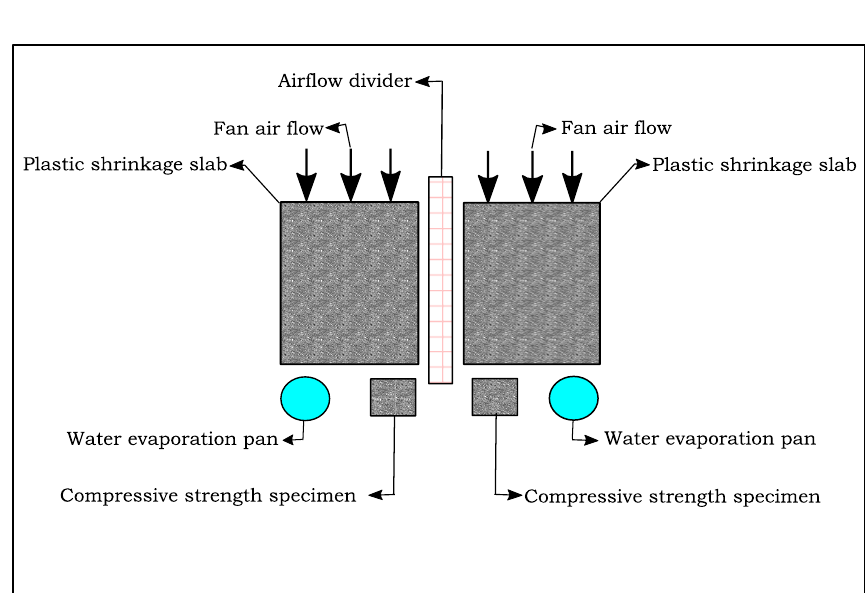
Figure 8. Schematic plan of the contents of the chamber.